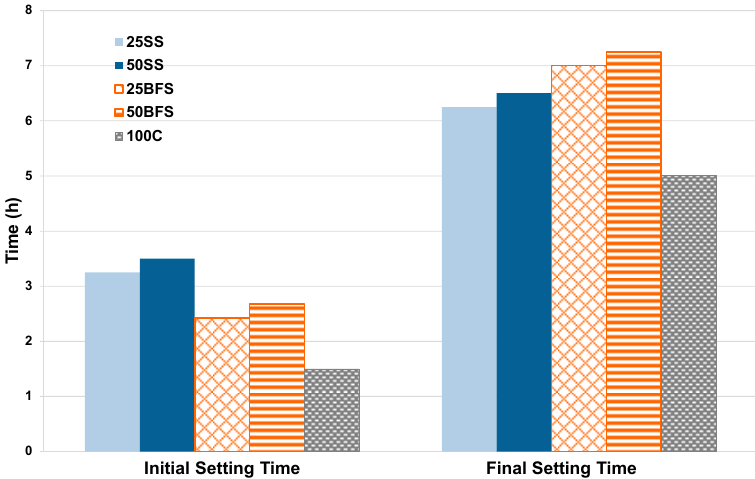
Figure 14. Evolution of the initial and final setting times.